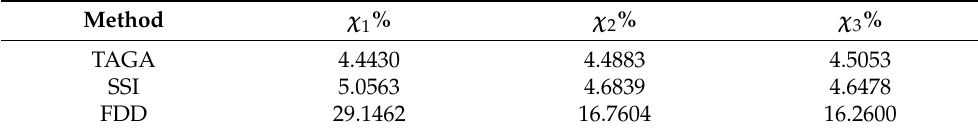
Table 6. Discrepancy between the estimated structural responses and the exact ones for the 3DoF system.